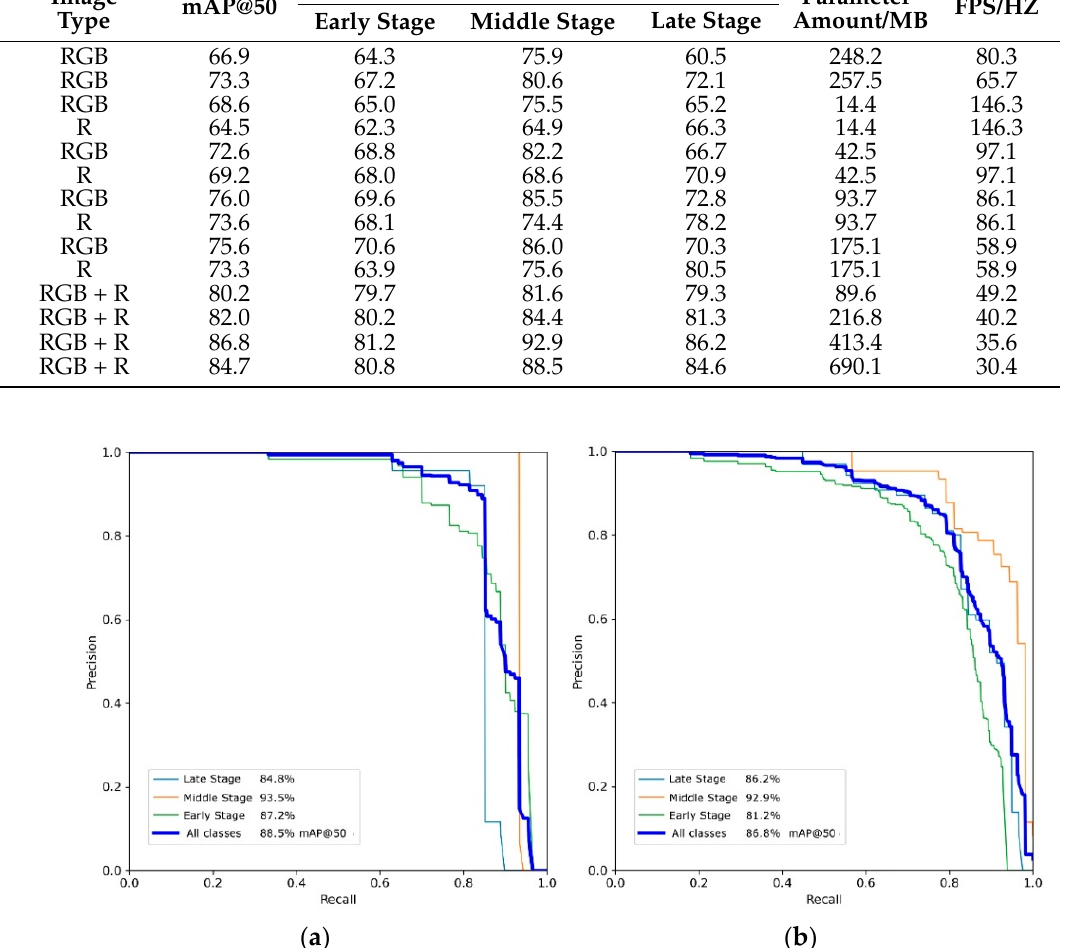
Figure 11. The Precision–Recall curves of MFTD models based on YOLOv5l: ( a ) The Precision–Recall curve of model K11 on the validation set of KP dataset, ( b ) the Precision–Recall curve of model C11 on the validation set of CP dataset.